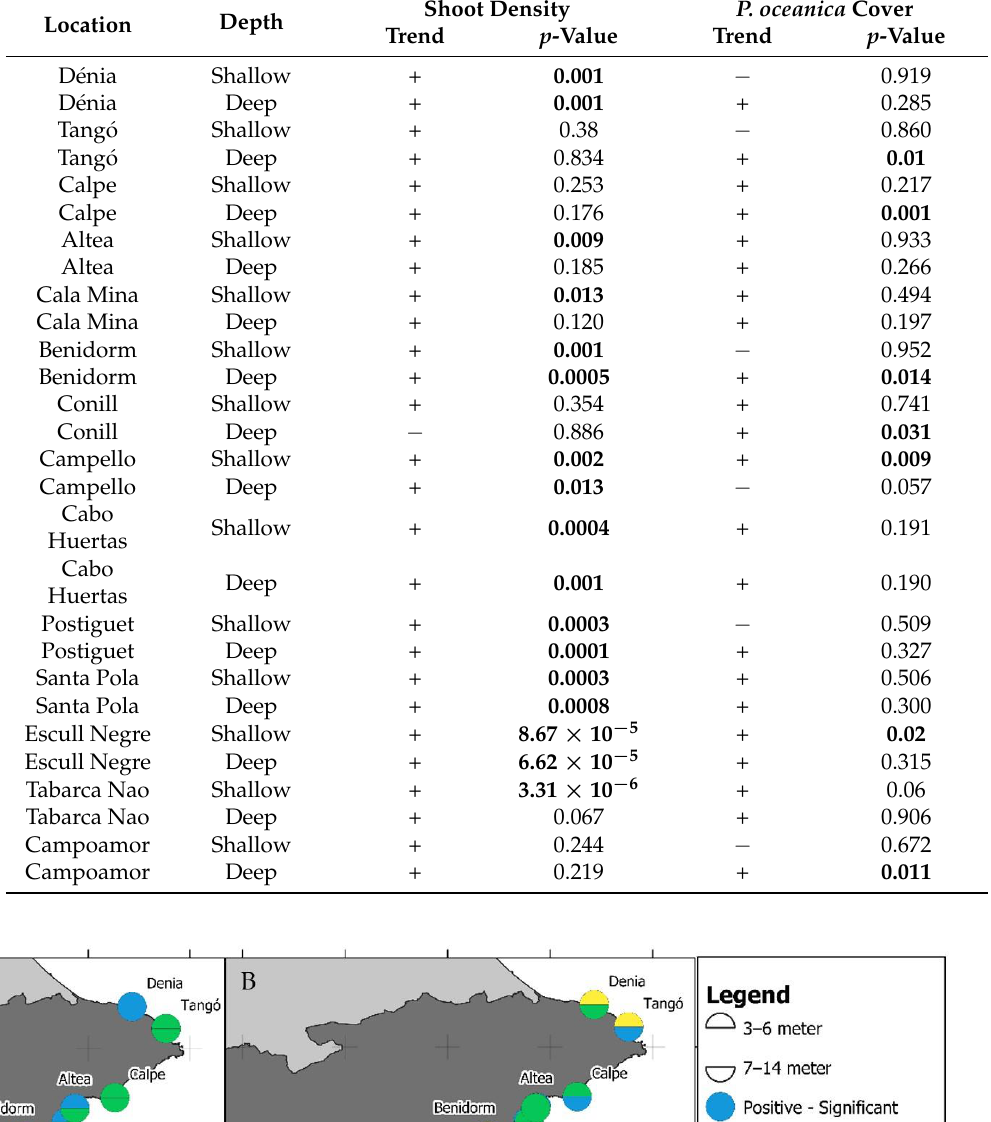
Table 2. Trends in P. oceanica cover and shoot density with time for different locations and depths. Trendline slope: “+”: variable increasing with time; “ − ”: variable decreasing with time. Significant results ( p < 0.05) are shown in bold.